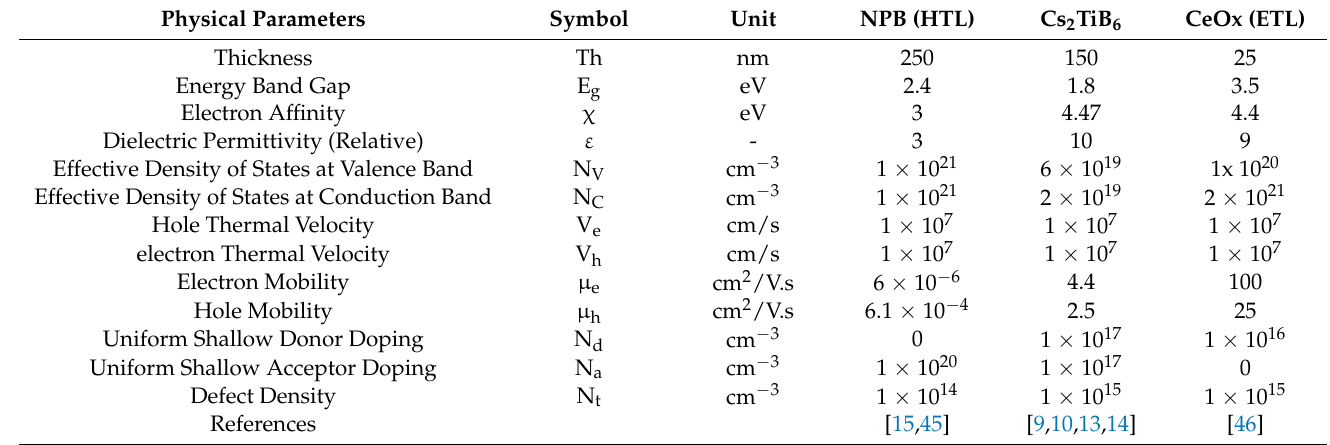
Table 5. Physical parameters of Cs2TiBr6 and NPB (HTL) and CeOx (ETL) were used in the simulation. Both NPB and CeOx are selected based on the closeness of the energy bandgap and electron affinity with the simulation